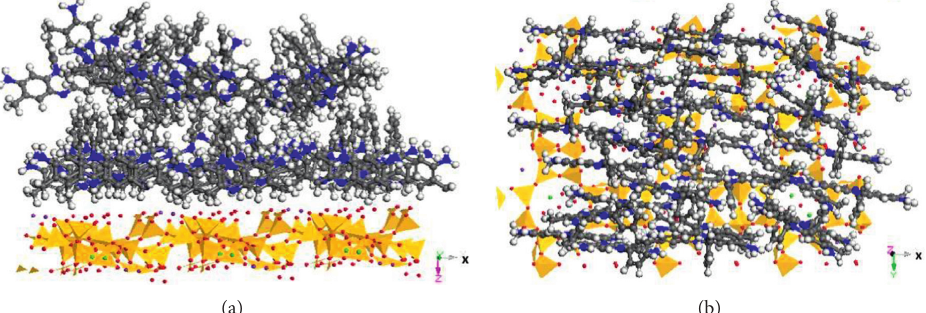
Figure 11: Molecular dynamic simulation showing SO uptake on the {001} surface (a) and projection along [001] (b) of ZEO. Supercell is made of 2 ax 1.5 b .